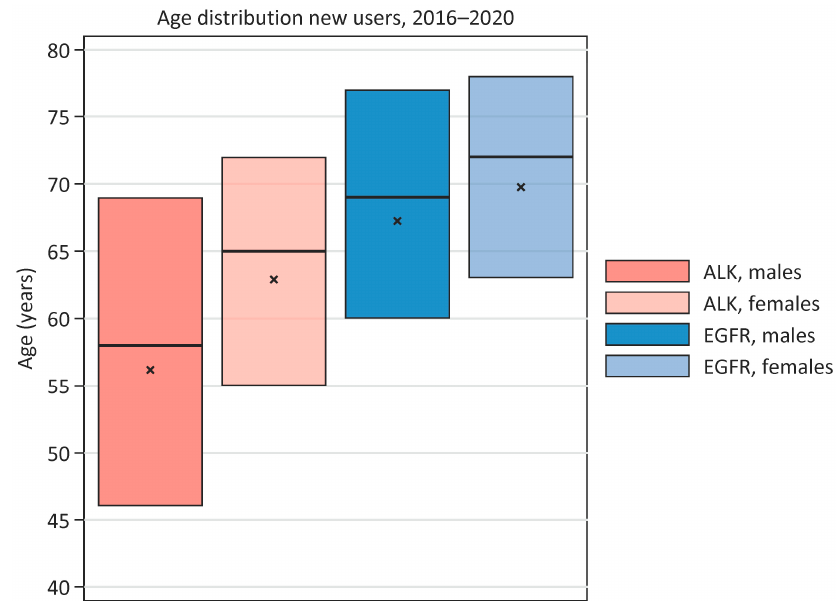
Figure 4. Age distribution among males and females at start of EGFR- or ALK-TKI treatment, respectively, in the period 2016–2020. Median is shown with horizontal line, mean with a cross, and range of bar represents 25- and 75-quartiles.